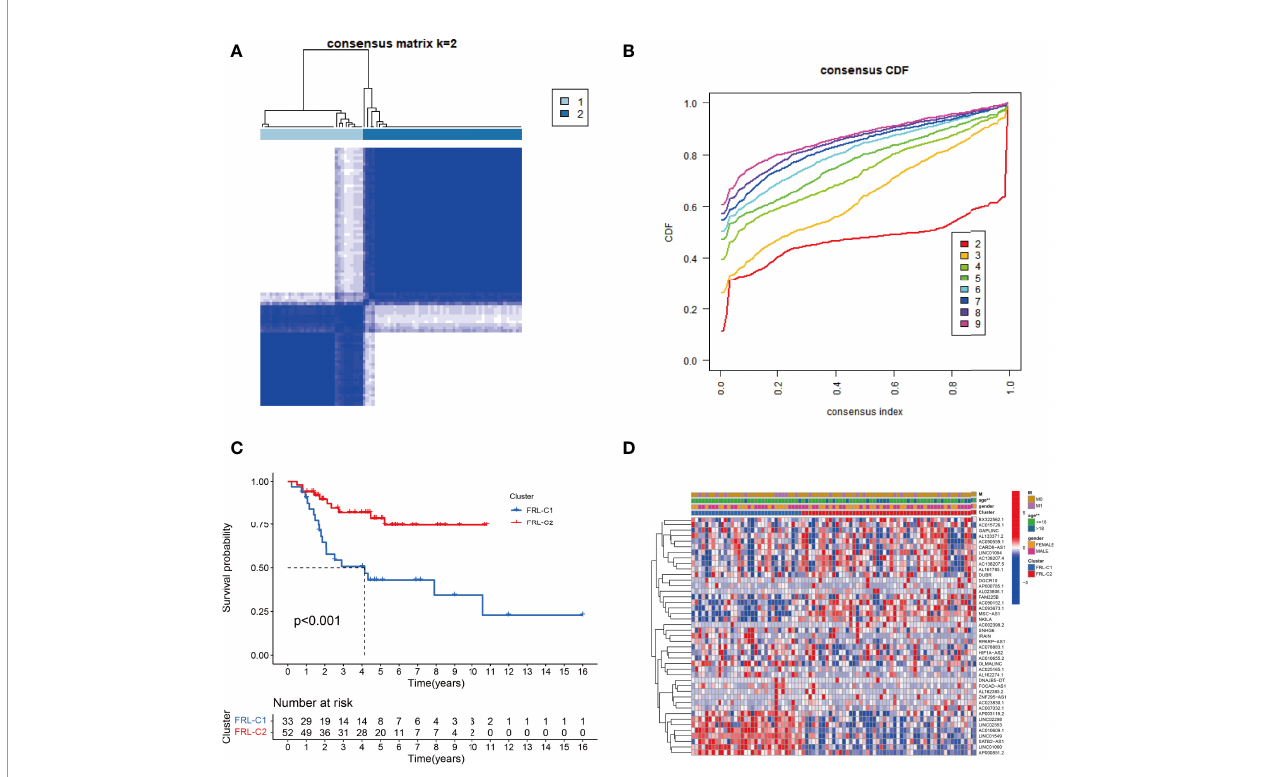
FIGURE 3 | The construction of FRL-based osteosarcoma subtypes. (A) Consensus clustering matrix for k = 2. (B) The cumulative distribution function curve for K = 2 – 10. (C) The survival analysis of two molecular subtypes. (D) Heatmap showing the differential expression of prognosis-related FRLs between two subgroups. FRLs, ferroptosis-related lncRNAs. **p <